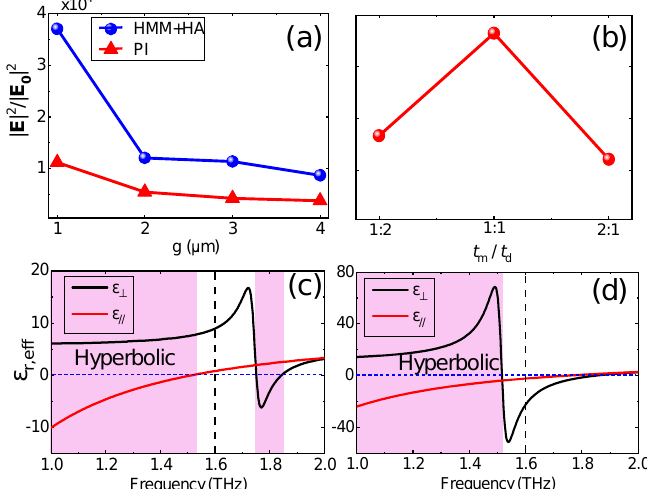
Figure 5. ( a ) Field enhancement factor versus the gap width for the dipole antenna on top of the PI substrate directly or sandwiched by the HMM with periodic hole arrays. ( b ) Field enhancement factor versus the ratio of the InSb and SiO 2 thicknesses, t m / t d . ( c , d ) Effective relative permittivities of the InSb-SiO 2 multilayers with ( c ) t m / t d = 1:2 or (d) t m / t d =